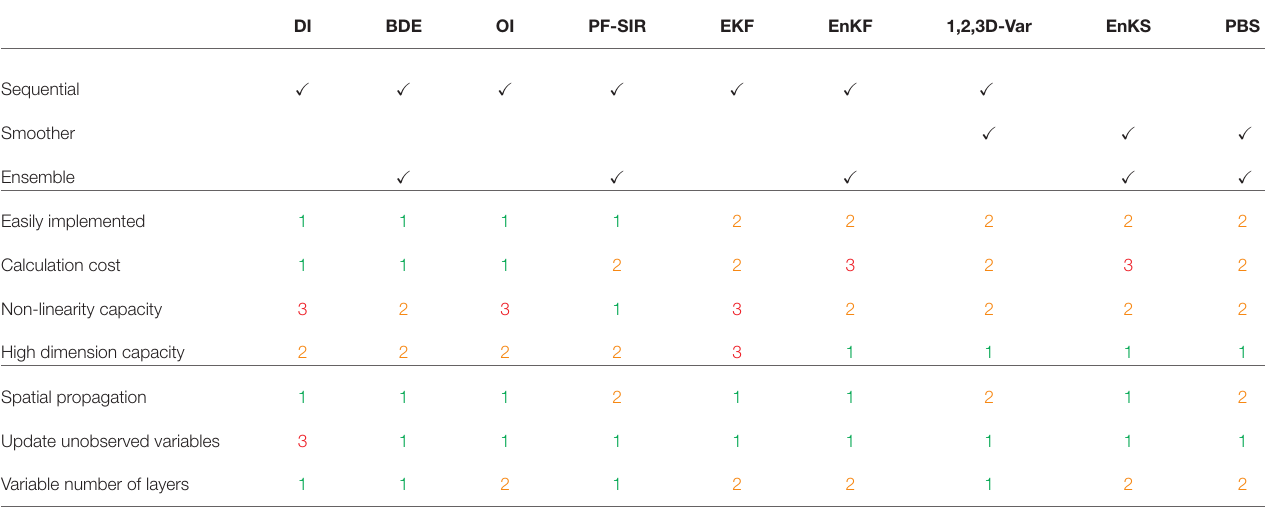
TABLE 2 | Description of the different methods to combine observations and model. DI BDE OI PF-SIR EKF EnKF 1,2,3D-Var EnKS PBS